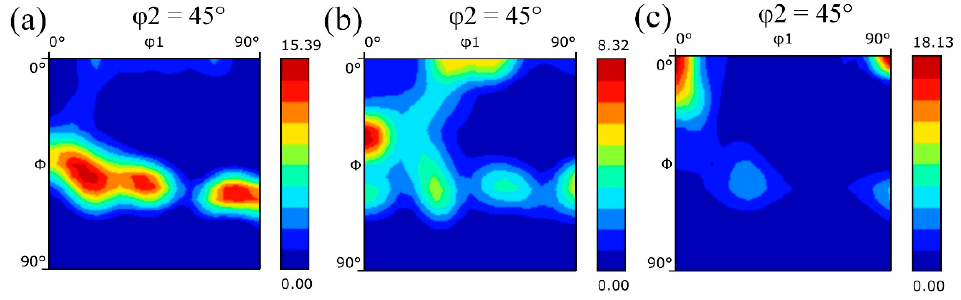
Figure 7. φ 2 = 45° ODF sections showing center textures ( a ) 800 °C—88%, ( b ) 800 °C—78%, ( c ) 800 Figure 7. ϕ 2 = 45 ◦ ODF sections showing center textures ( a ) 800 ◦ C—88%, ( b ) 800 ◦ C—78%, °C—67%. ( c ) 800 ◦ C—67%.